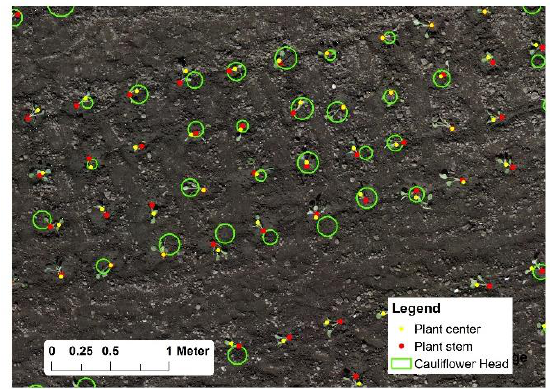
Figure 4: Comparison of location of the automatically computed plant position vs. the stem of the plant and the diameter of the final cauliflower head